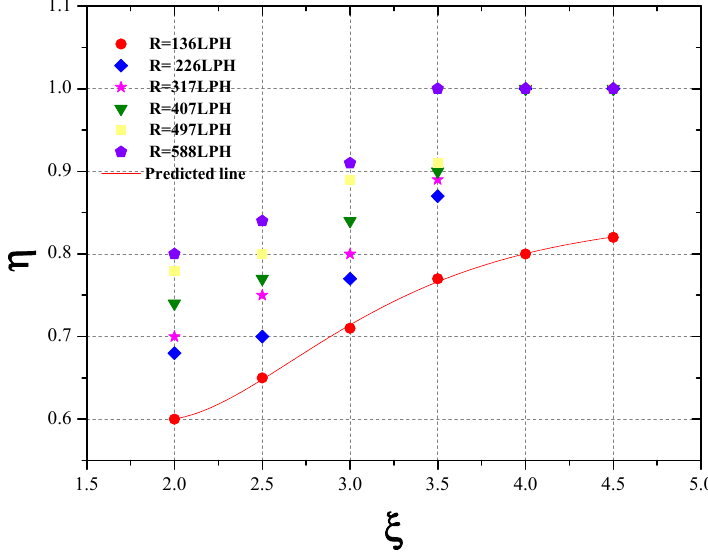
Figure 10. Dimensionless maximum oscillation distance of bubbly flow at the various aspect ratios.